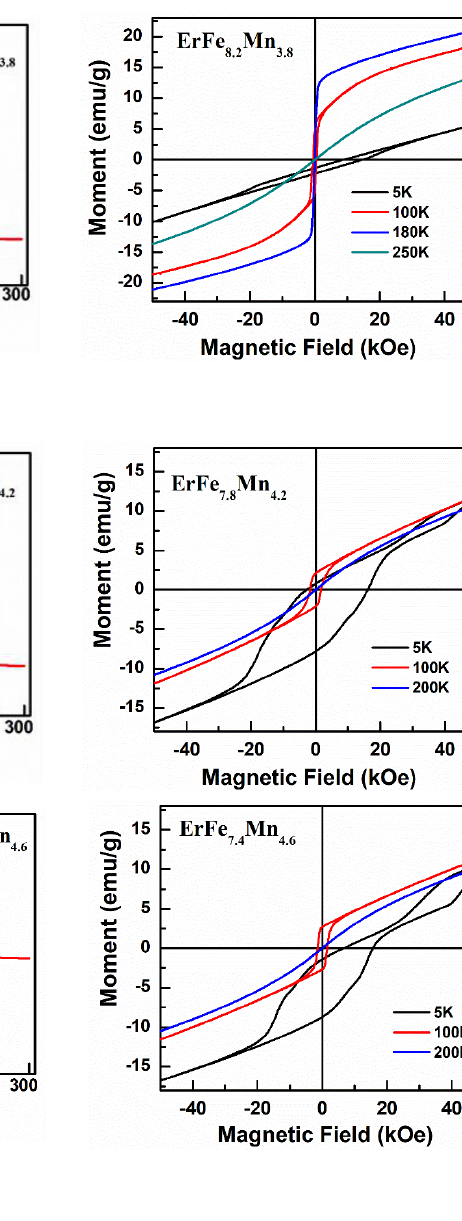
Figure 4. The magnetic phase diagram of ErFe x Mn 12−x (7.0 ≤ x ≤ 9.0) series alloys.